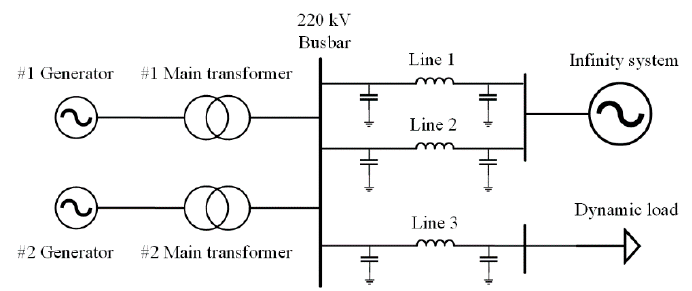
Figure 11. Equivalent wiring diagram of dynamic model experiment.